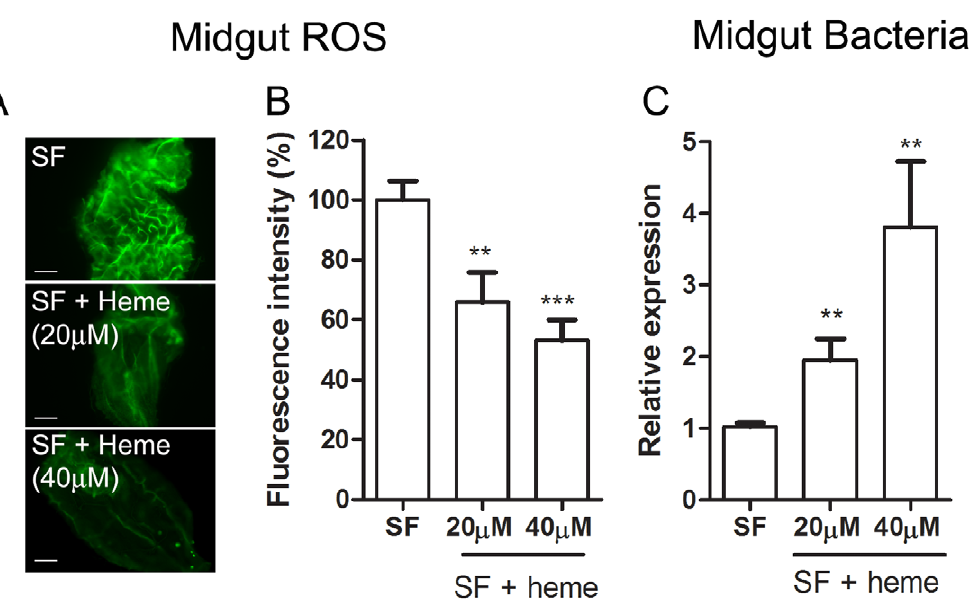
Figure 6. Heme decreases ROS levels in the midgut and allow proliferation of intestinal microbiota. Female Aedes aegypti were fed ad libitum for five days with sucrose supplemented with heme (20 and 40 m M). (A) Representative images of midgut ROS after heme treatment. Scale bar – 100 m m. (B) Fluorescence associated with individual midguts was quantified with ImageJ software. The number of midguts used was: SF – 24, SF + heme (20 m M) – 23, SF + heme (40 m M) – 21. ** P , 0.01. *** P , 0.0001 (ANOVA followed by Tukey’s Multiple Comparison Test – GraphPad Prism). (C) Gut bacteria was assessed through qPCR from pools of 10 midguts. 8 pools from each condition were used. ** P , 0.01 (T-test – GraphPad Prism).